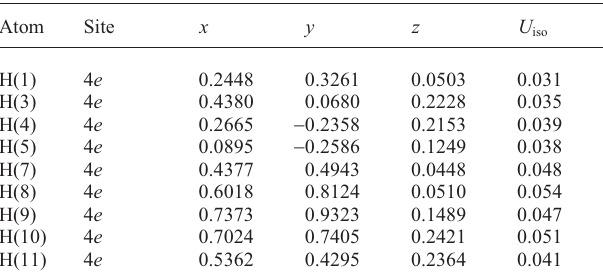
Table 2. Atomic coordinates and displacement parameters (in Å 2 )